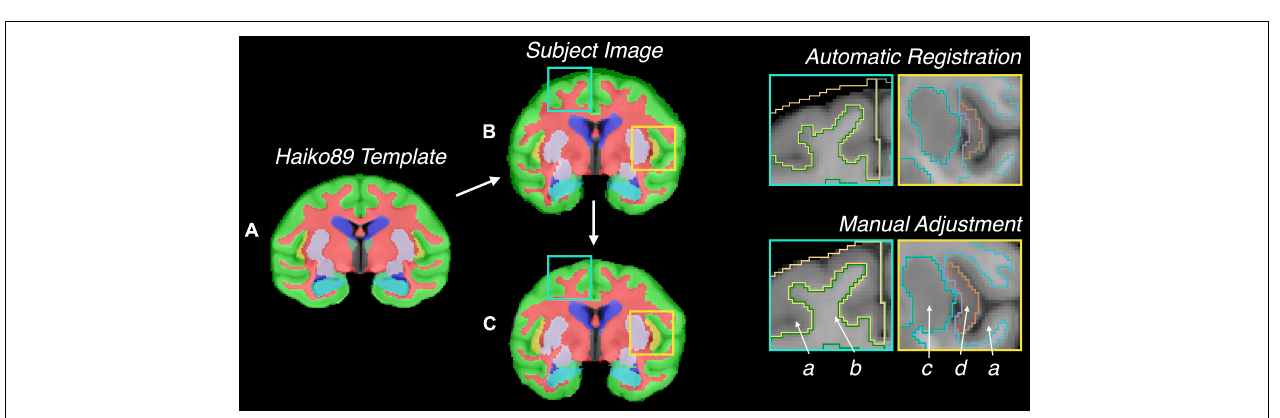
FIGURE 2 | Illustration of semi-automatic registration for validation of the atlas for MRI data. (A) Atlas on Haiko89 template, (B) atlas transformed to Subject #036 by automatic registration, (C) final atlas registered to Subject #036 with additional manual adjustment. Highlighted squares indicate locations of automatic registration errors. Labels: (a) cerebral cortex, (b) cerebral white matter, (c) putamen, (d) insula.